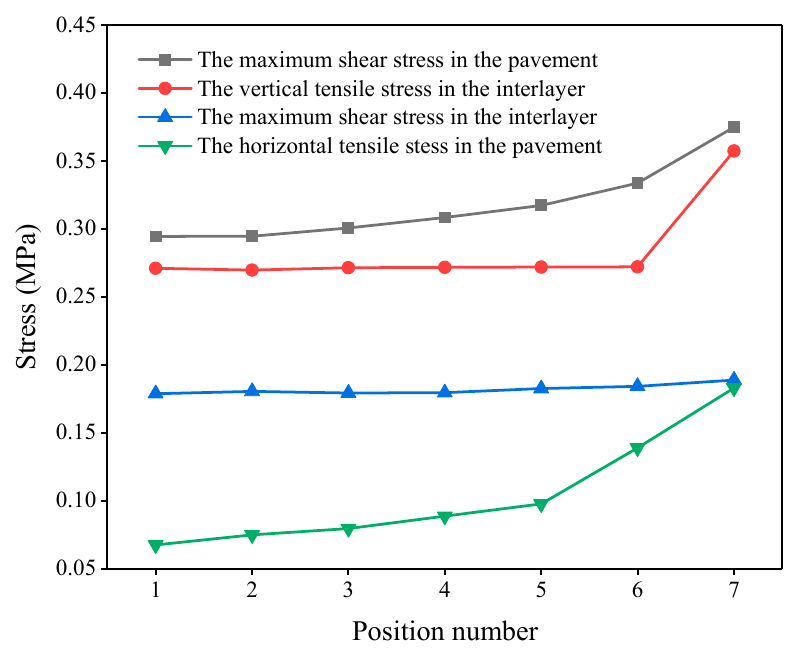
Figure 2. Lateral stresses in the pavement at different loading positions.